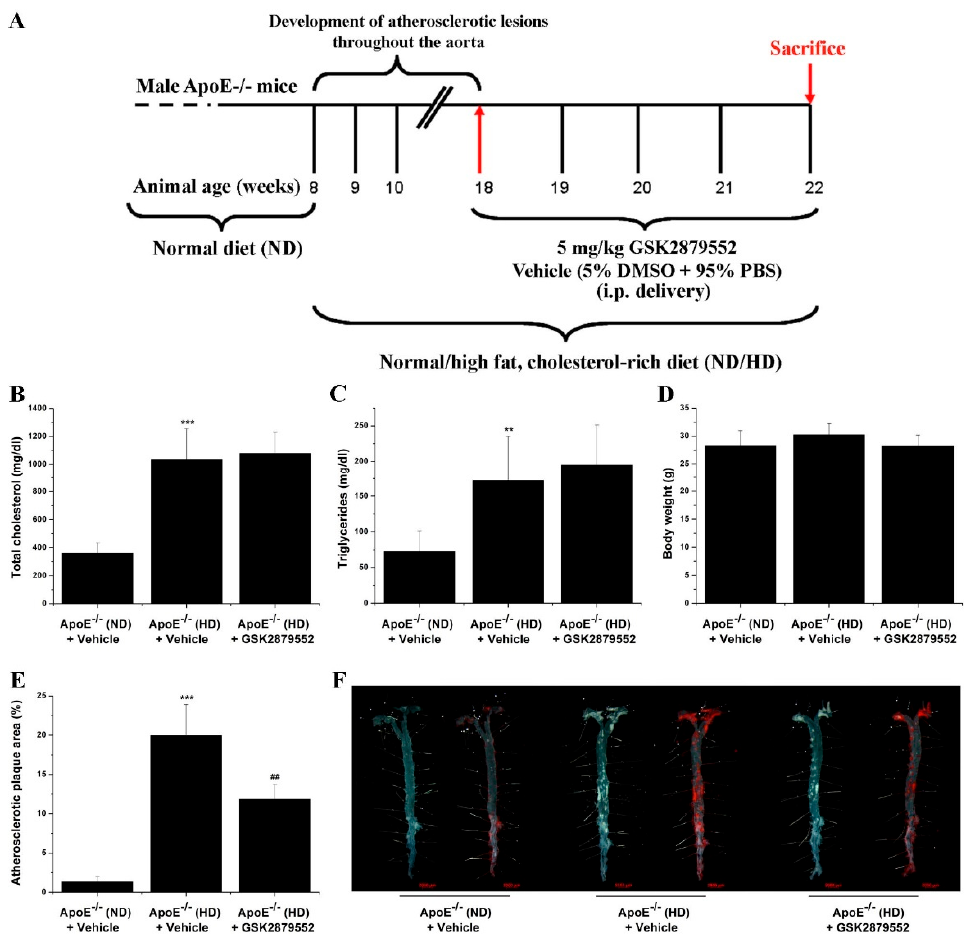
Figure 5. LSD1-related signaling pathways contribute to atherosclerotic lesion formation in ApoE- /- mice. ( A ) Schematic depiction of the general experimental set-up to promote atherosclerotic lesion formation throughout the aorta of ApoE-/- mice and the animal treatment strategy with the GSK2879552 pharmacological inhibitor. ( B – D ) Evaluation of plasma total cholesterol and triglyceride levels and body weight of ApoE-/- mice at the end of the treatment procedure. ( E ) Quantification of atherosclerotic lesion area in each animal group. ( F ) Representative images of en face Oil Red O (ORO) staining depicting the extent of atherosclerotic lesion formation throughout the aorta of ApoE-/- mice. The aortas were photographed in the absence and presence of the lipid staining solution. n = 6, ** p < 0.01, *** p < 0.001. p -values were taken in relation to ApoE-/- (ND) condition. ## p < 0.01. p -value was taken in relation to ApoE-/- (HD)